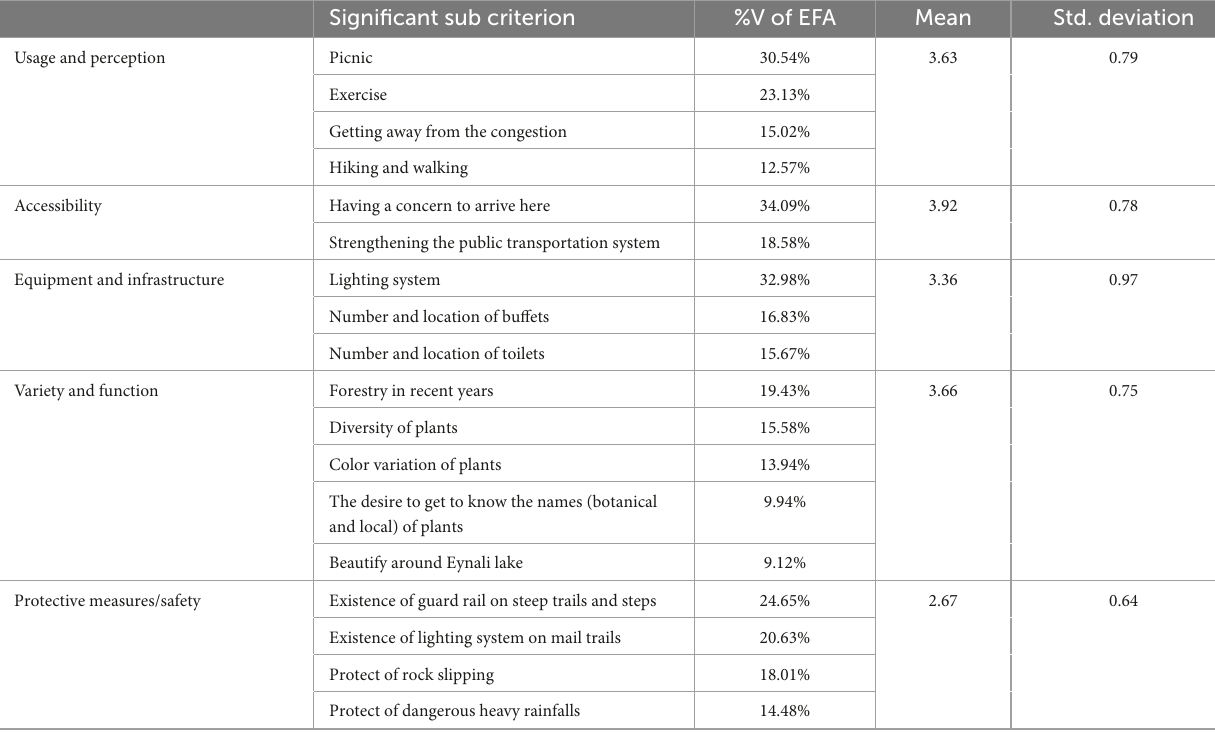
TABLE 4 Ranking the criteria and determining importance according to